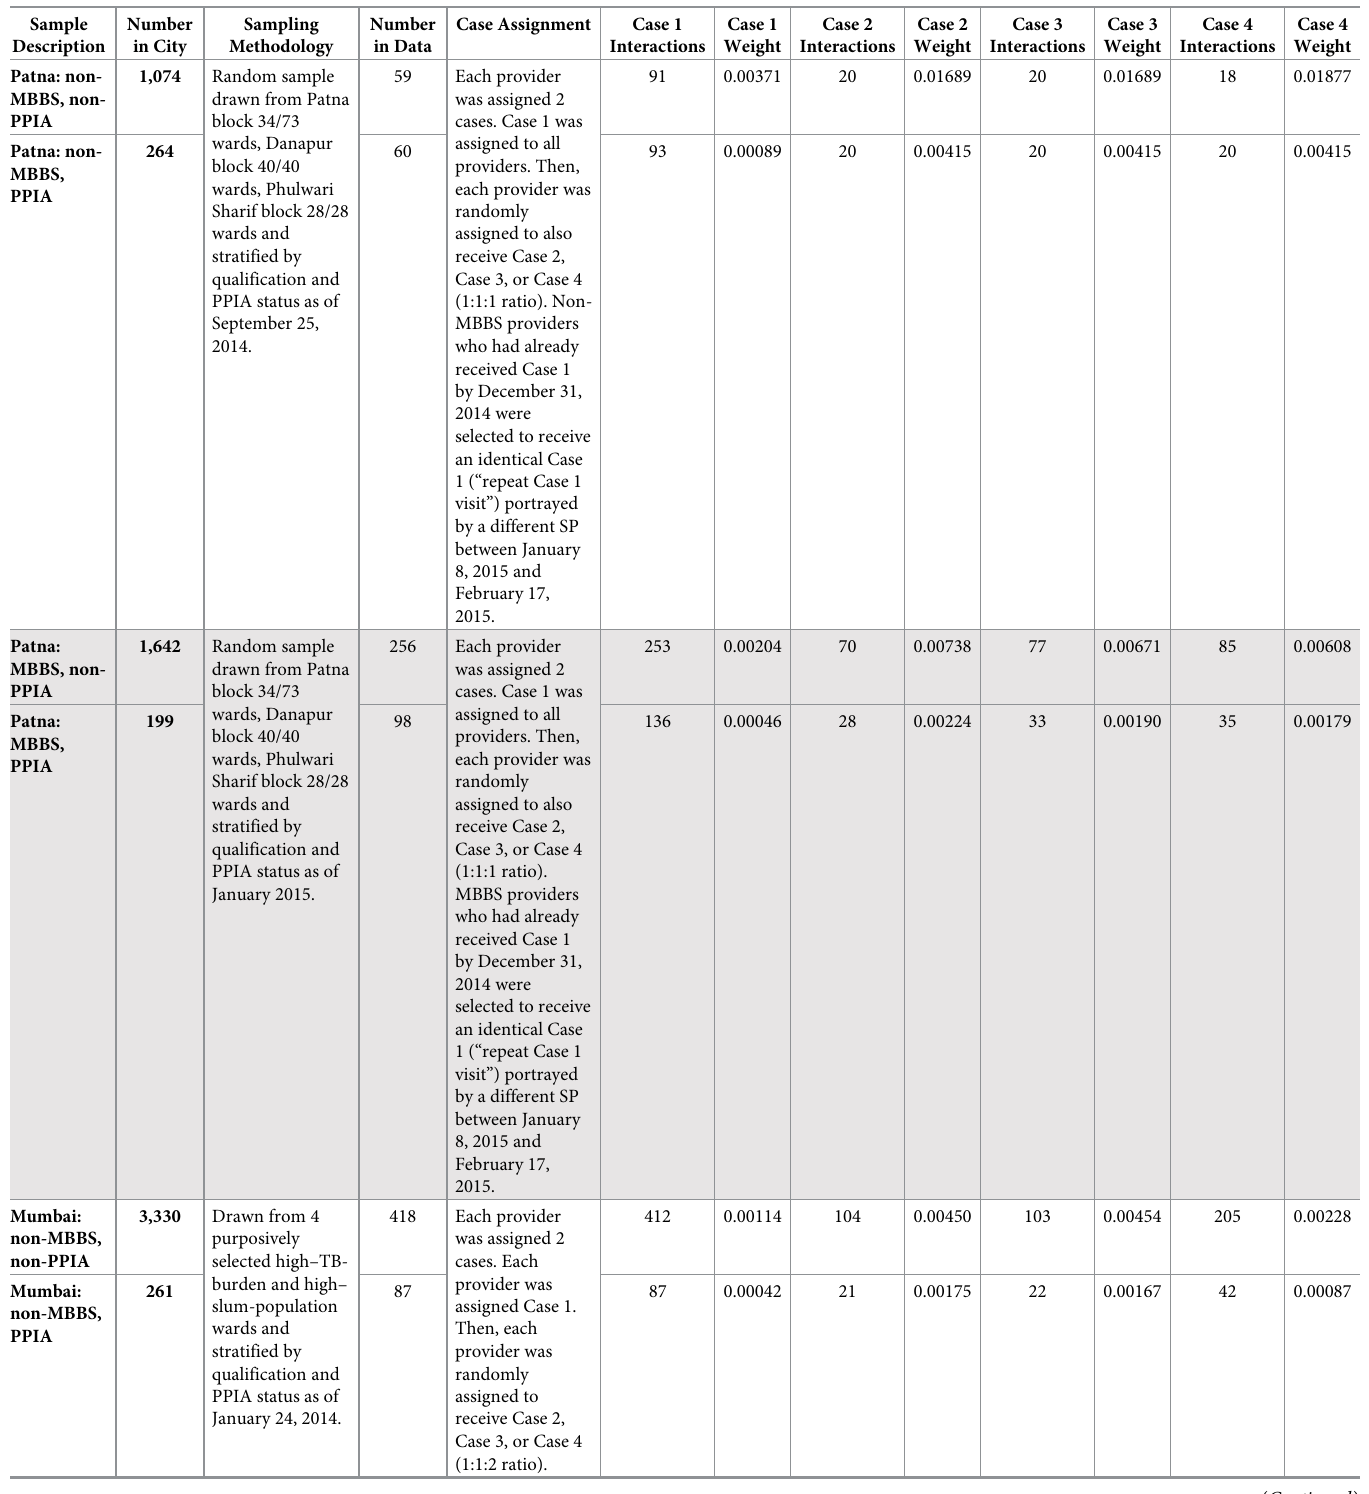
Table 1. Sampling and weighting